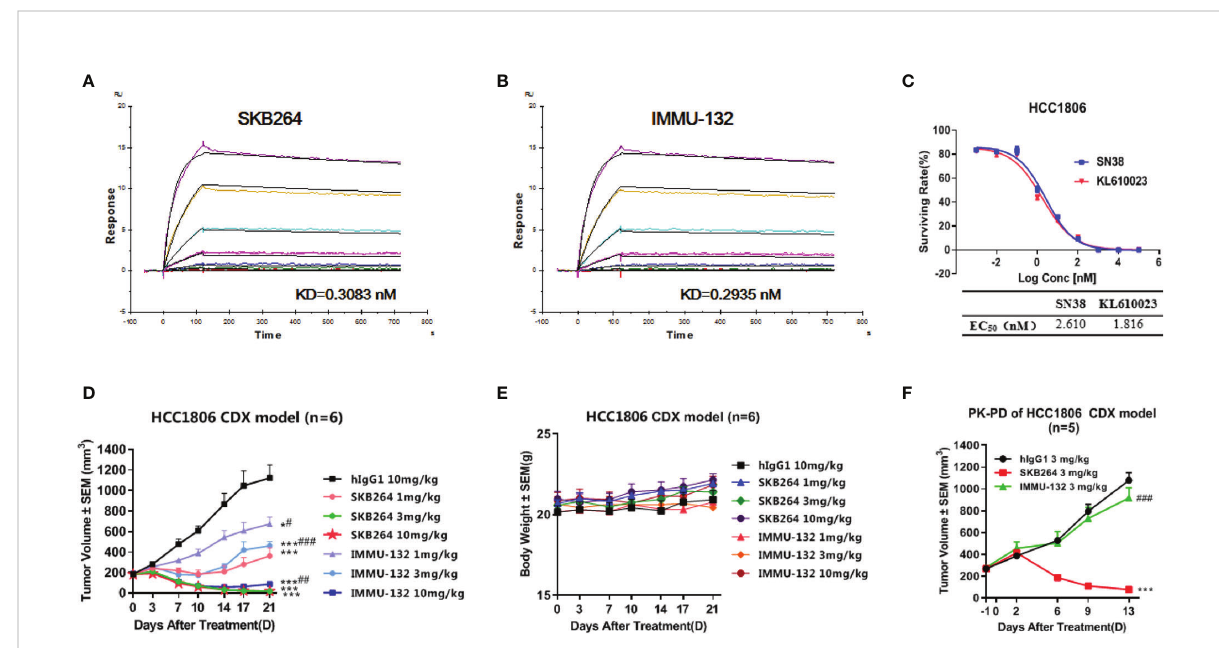
FIGURE 7 (A) Dynamic af fi nity of SKB264 to human TROP2. (B) Dynamic af fi nity of IMMU-132 to human TROP2. (C) In vitro inhibitory effect of KL610023 and SN-38 on HCC1806 cell growth (duplicates, mean ± SEM). (D) Antitumor ef fi cacy of SKB264 and IMMU-132 in the HCC1806 xenograft model. The tumor-bearing mice were intravenously treated with SKB264 or IMMU-132 at dosages of 10, 3, and 1 mg/kg twice weekly, n = 6. Two-tailed paired t -test, * p < 0.05; *** p < 0.001 ( vs . hIgG1); # p < 0.05; ## p < 0.01; ### p < 0.001 ( vs . the same dose of SKB264). (E) Body weight of the tumor-bearing mice ( n = 6). (F) Antitumor ef fi cacy of single-dose SKB264 and IMMU-132 in the HCC1806 xenograft model in PK-PD ( n = 5). Two-tailed paired t -test, *** p < 0.001 ( vs . hIgG1); ### p < 0.001 ( vs .